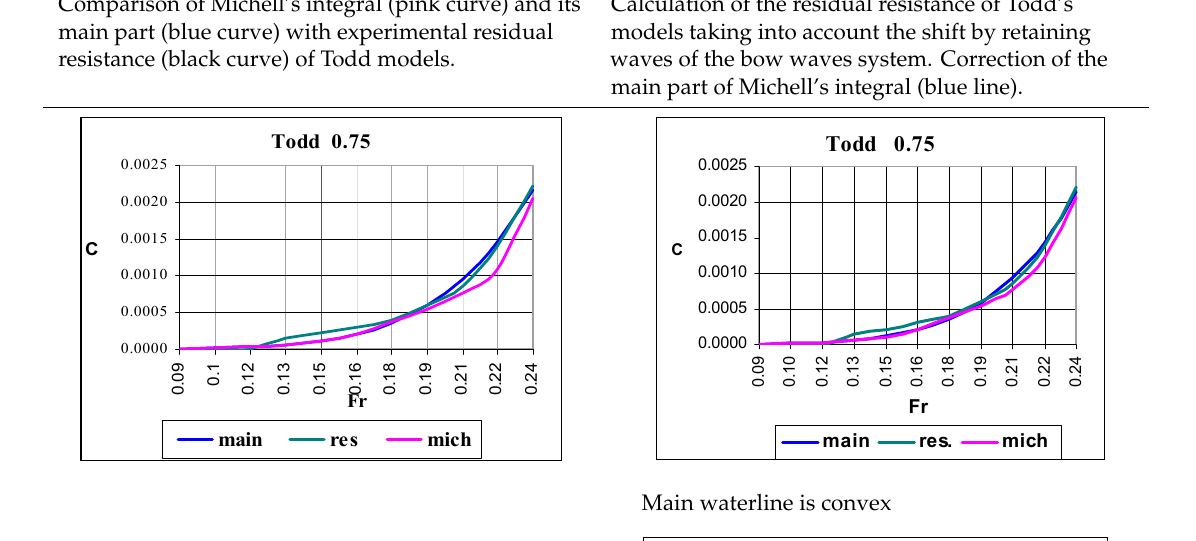
Calculation of the residual resistance of Todd’s models taking into account the shift by retaining waves of the bow waves system. Correction of the main part of Michell’s integral (blue